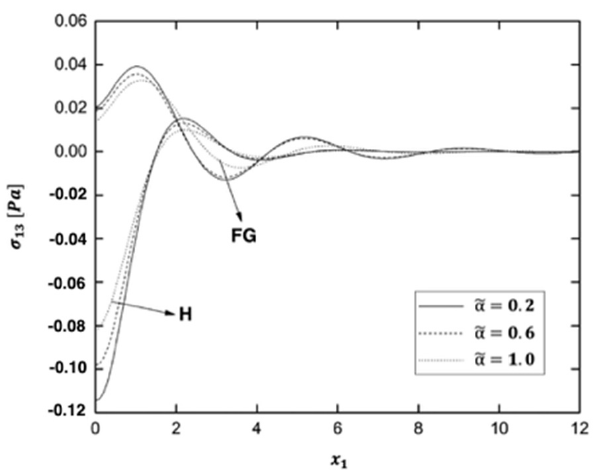
Figure 5. Variation of the thermal stress wave σ 13 along x 1 –axis in the functionally graded (FG) and homogeneous (H) anisotropic fiber-reinforced plates under different fractional order parameters.